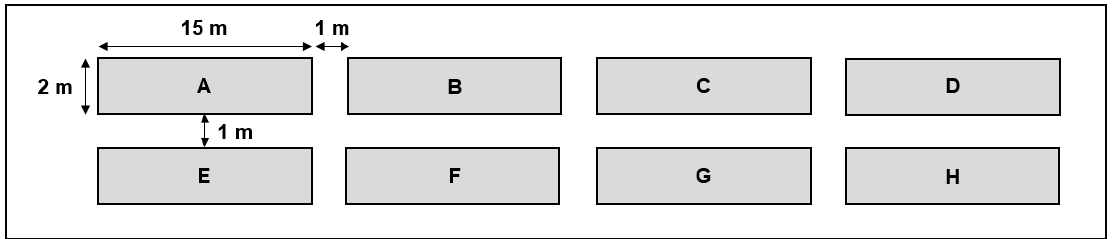
Figure 1. Experimental plots for greenhouse studies. ( A , E ): Plots for crop plants cultivated on the soil without imicyafos treatment; ( B , F ): Plots for crop plants cultivated on the soil treated with imicyafos; ( C , G ): Plots for bare soil without imicyafos treatment; ( D , H ): Plots for bare soil treated with imicyafos. The plots ( C , D , G , H ) had no crop planting during the experiments.